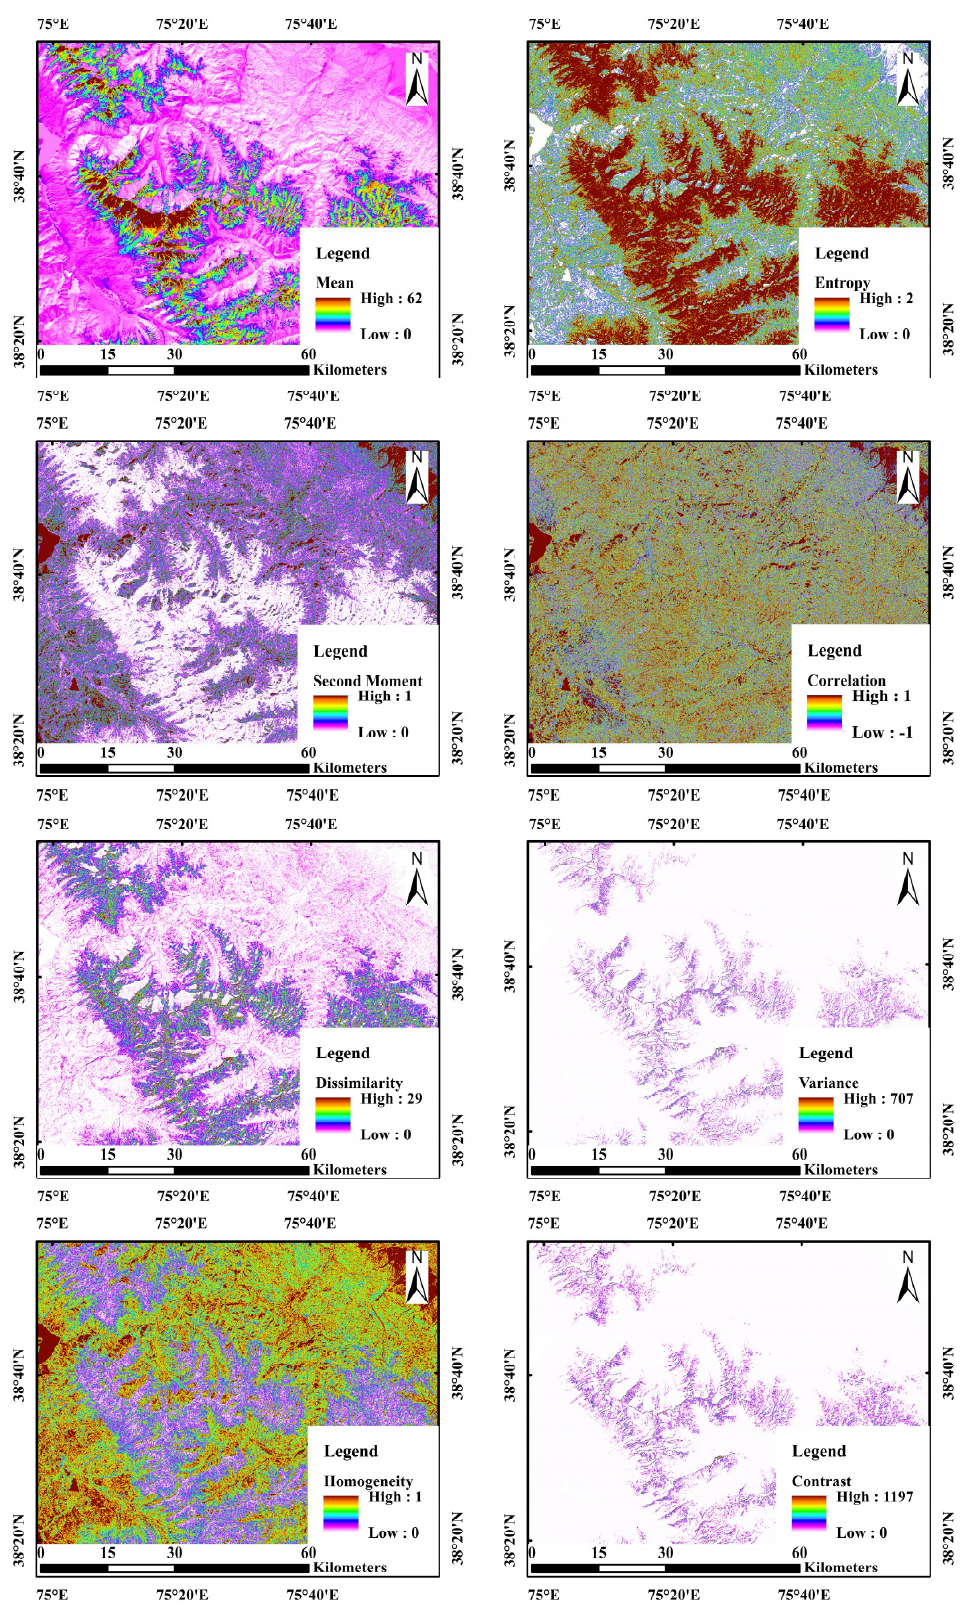
Figure 5. Examples of texture features for the Random Forest classification method for a portion of the study